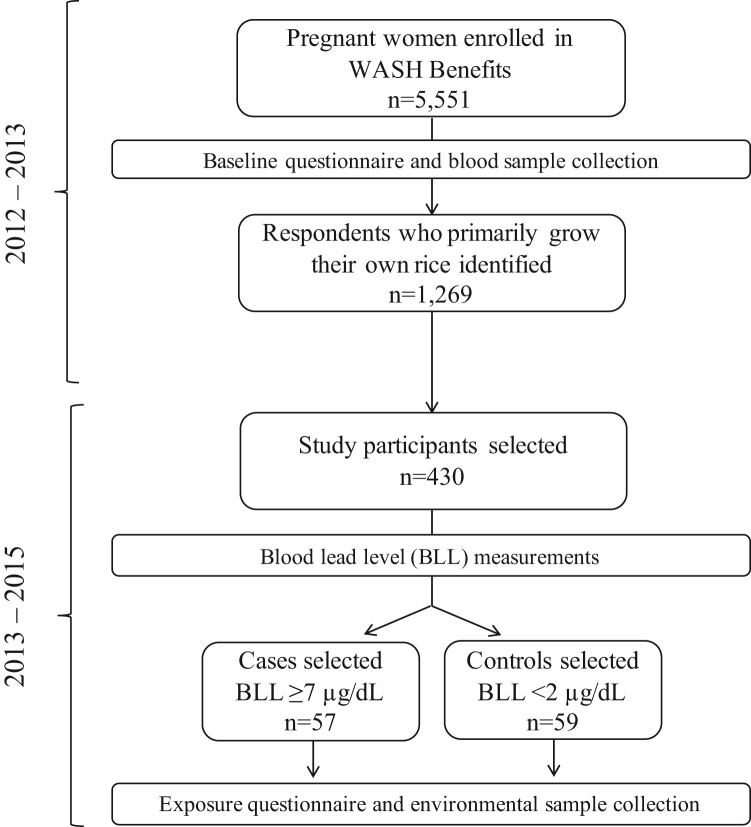
Overview of participant selection and research activities in Mymensingh, Tangail, and Kishoreganj districts between 2012 and 2015.